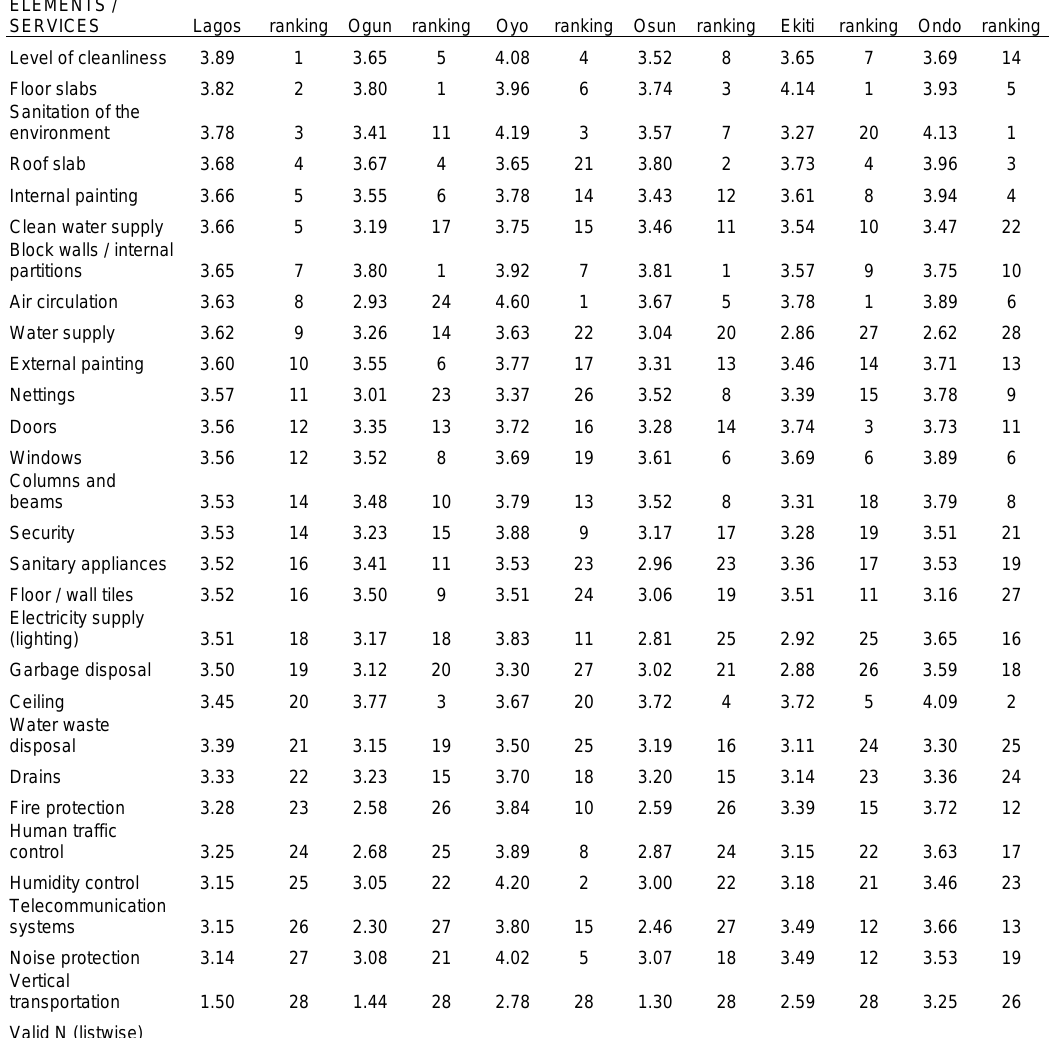
Table 10: Operational state of building elements and services in public